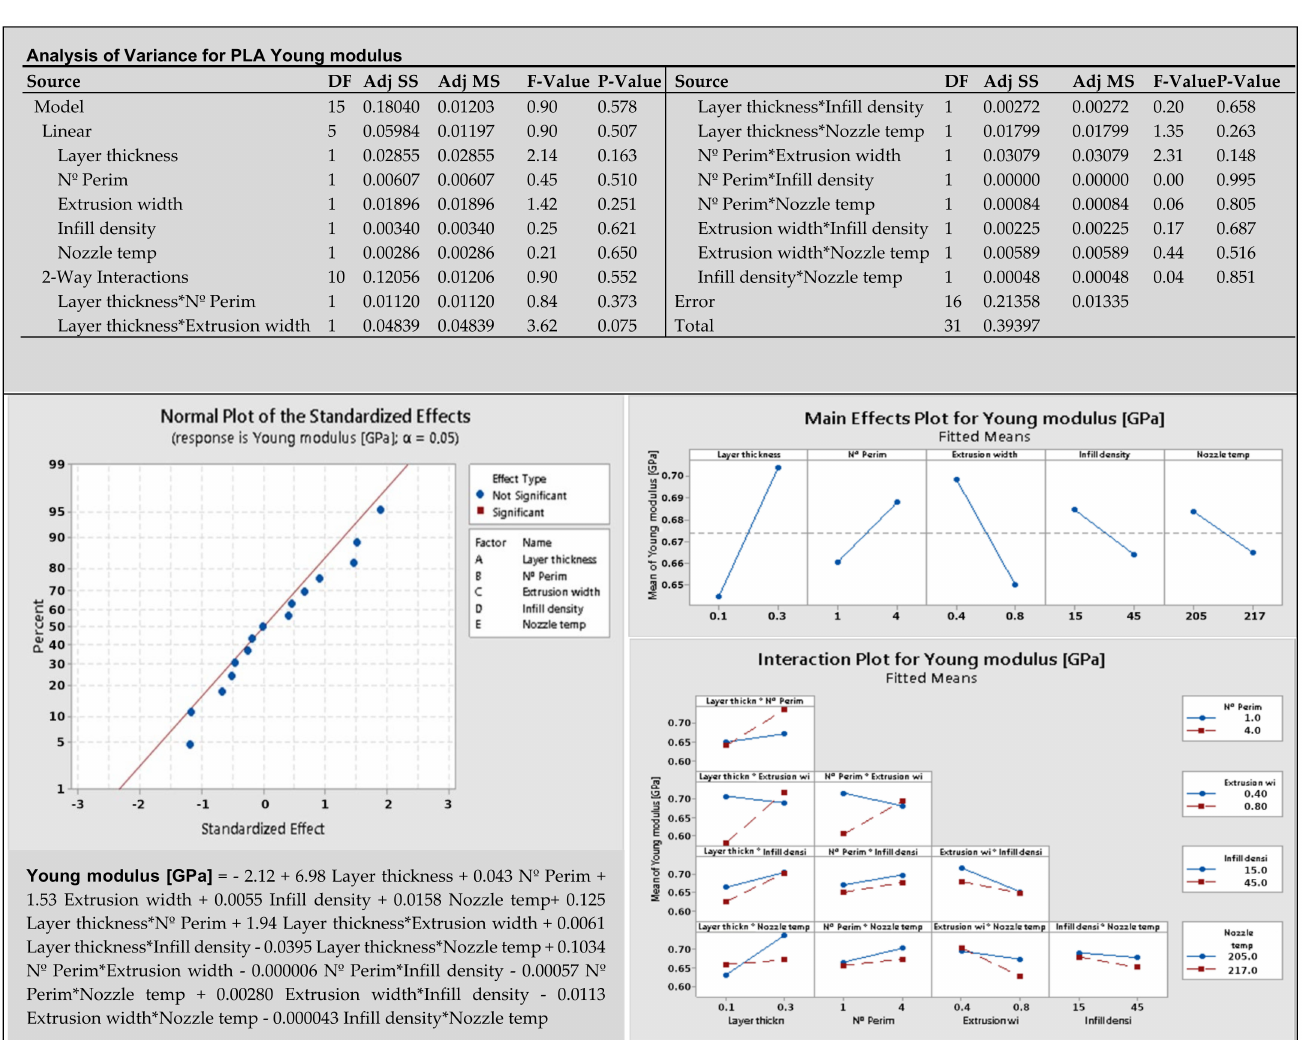
Figure 6. Graphical presentation of results for PLA young modulus. The p -values of factors and interactions are listed in analysis of variance. Statistically significant factors and interactions at the significance level α = 0.05 are marked in red on the normal plot. The first normal plot for the Young modulus in Figure 6 does not contain statistically significant factors. The second normal plot for length accuracy in Figure 7 shows significant factor A—layer thickness, BD—number of perimeters*infill density, and CE—extrusion width*nozzle temperature. The main effects plot has non-horizontal lines through the X-axis for factors that are important for the response. The non-parallel lines on the interaction plot indicate the relationship between the factors. Polynomial models in Figures 6 and 7 are in un-coded units and should be reduced by omitting factors and interactions with low